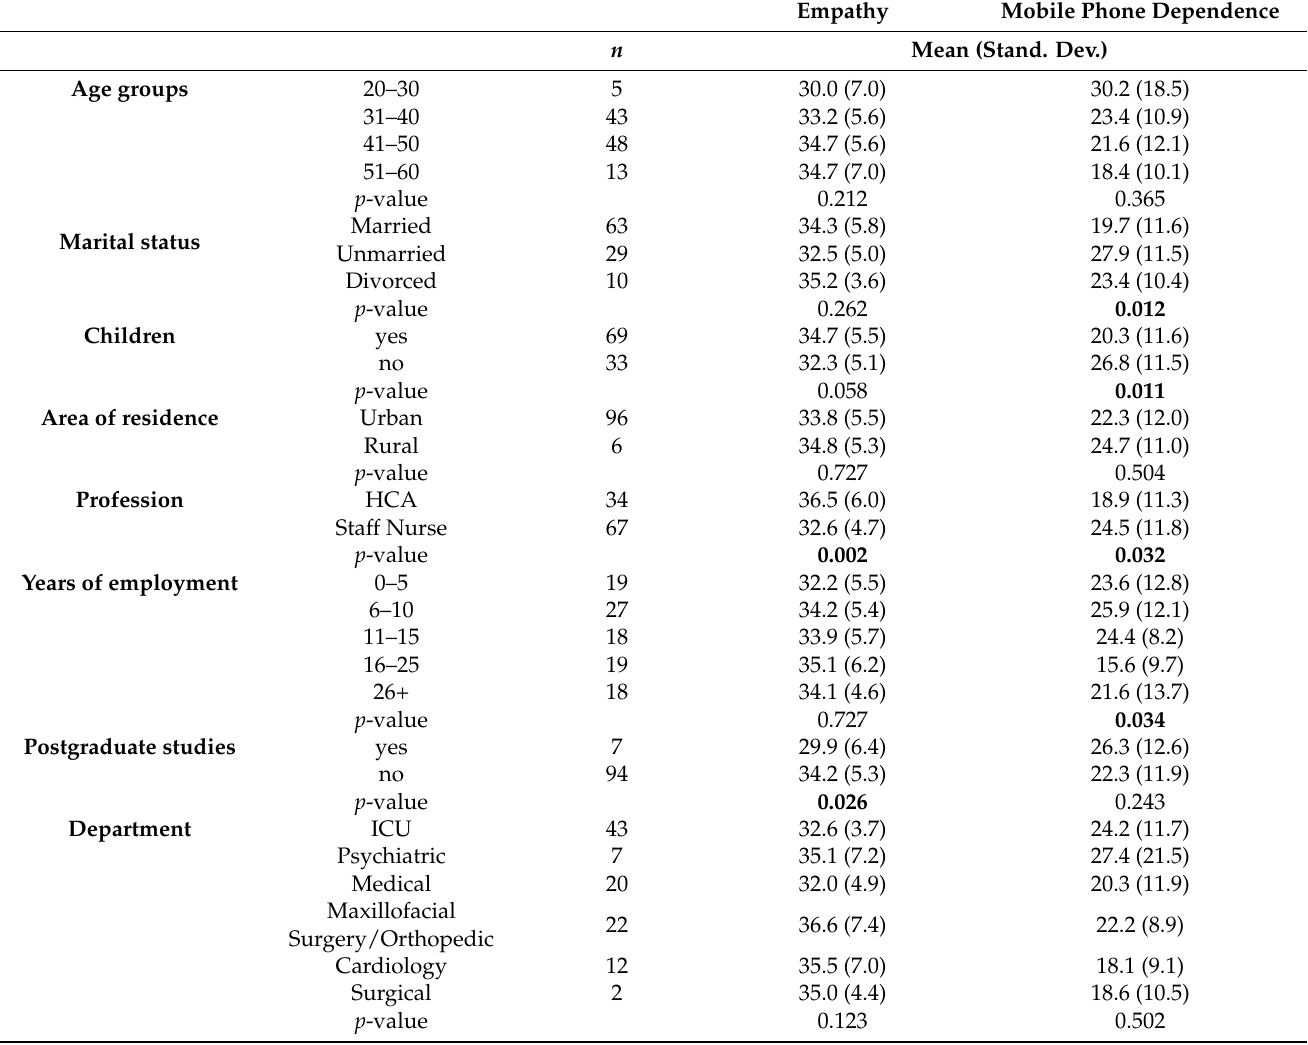
Table 3. Empathy and dependence scale scores in study participants according to demographic characteristics. Empathy Mobile Phone Dependence n Mean (Stand.